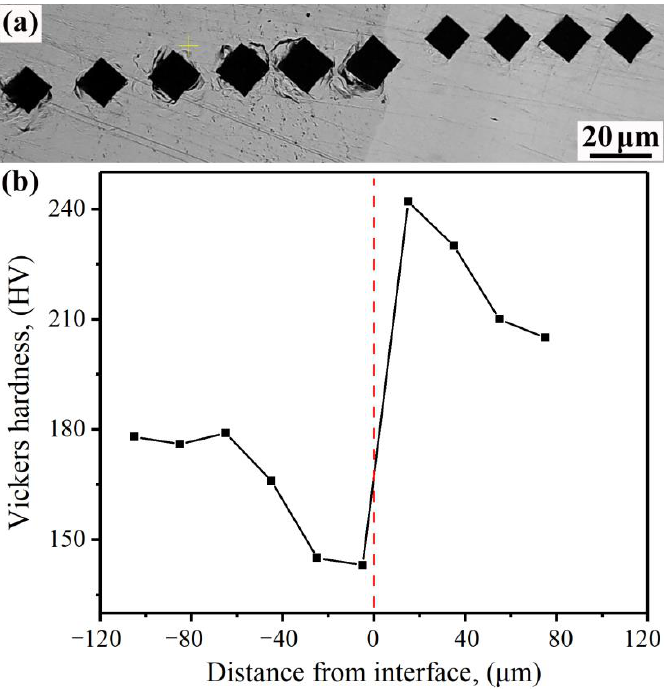
Figure 8. Hardness distribution of the rebar composite interface: ( a ) locations of test points and ( b ) microhardness.